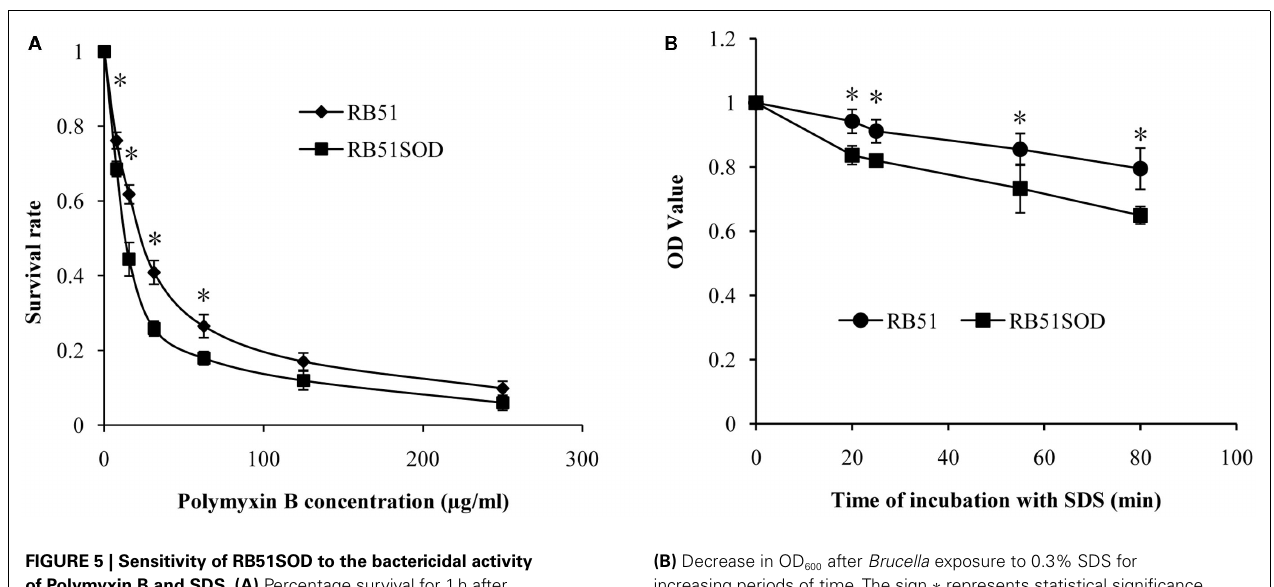
FIGURE 5 | Sensitivity of RB51SOD to the bactericidal activity of Polymyxin B and SDS. (A) Percentage survival for 1h after exposure to the indicated range of Polymyxin B concentrations.